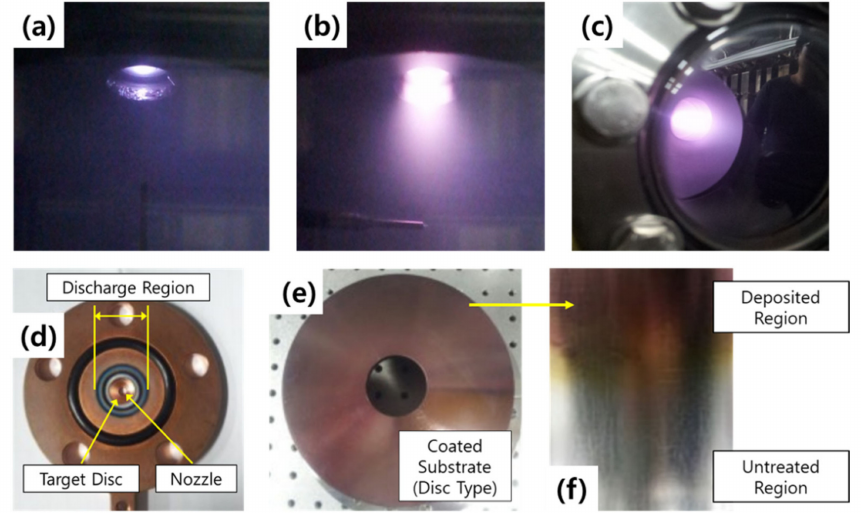
Figure 9. The developed hollow-anode plasma source for material applications: formation of plasma jets by using ( a ) a DC power (25 W), ( b ) a pulsed DC power (40 W), ( c ) RF power (100 W), ( d ) the used anode and target disc ( e ) and ( f ) copper thin films deposited on a stainless